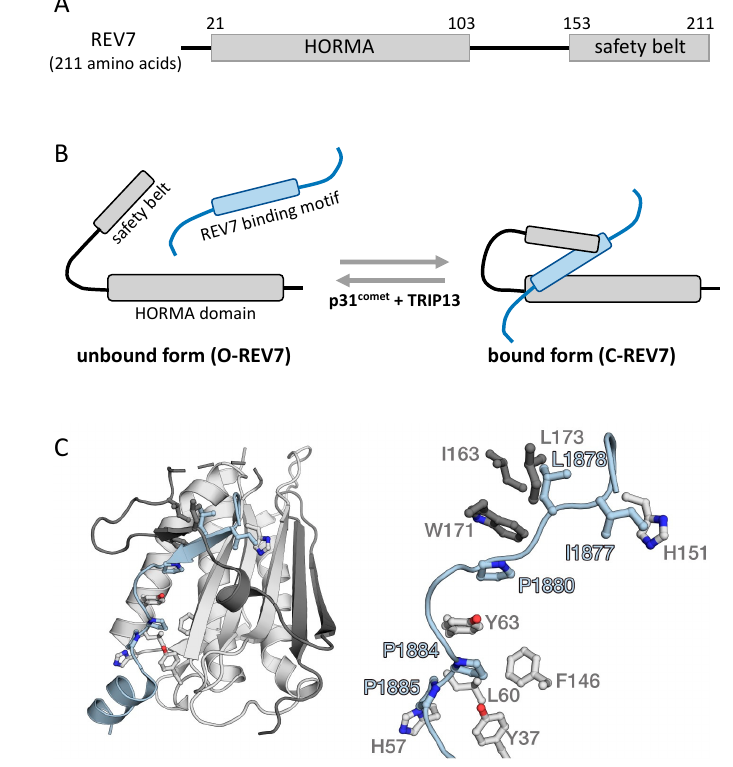
Figure 1. Structure of REV7 in complex with binding partners. ( A ) Domain structure of REV7. REV7 is composed of 211 amino acid residues, with a HORMA domain in its middle region and a “safety belt” region in its C-terminus [27]. ( B ) Bound and unbound forms of REV7. When REV7 unbinds its interaction partners, the safety belt structure is open (O-REV7), and when it binds its interaction partners, the safety belt structure is closed (C-REV7). The conformational change from C-REV7 to O-REV7 is catalyzed by p31 comet and TRIP13. TRIP13, thyroid hormone receptor-interacting protein 13. ( C ) Structure of human REV7(R124A) in complex with a human REV3 fragment including residues 1877–1885 (PDB entry 3ABD). REV7 and REV3 are shown in gray and light blue, respectively. The C-terminal region of REV7 is shown in a darker color. A detail of the interactions between REV7 and REV3 is shown in the right panel. I1877, L1878, P1880, P1884, and P1885 of REV3 in the consensus sequence for REV7 binding, ΦΦ xPxxxpP, are shown as ball-and-stick models and labeled. Amino acid residues of REV7 involved in the interactions with the REV3 fragment are also shown as ball-and-stick models and labeled.